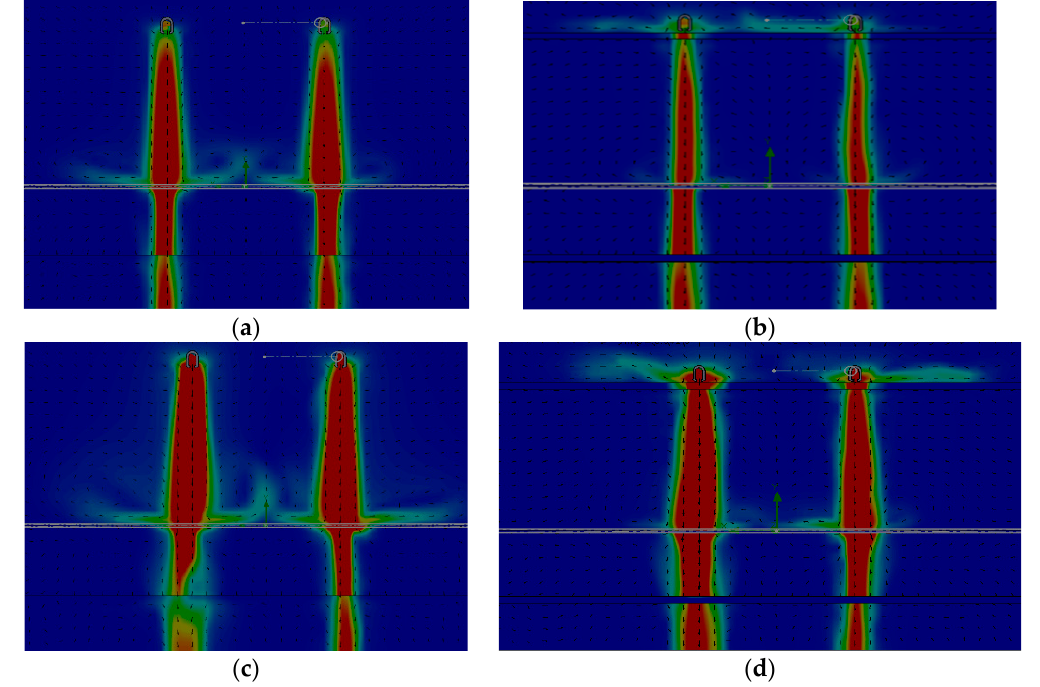
Figure 13. Fluid flow rate distribution patterns for: Q = 0.00025 m 3 /s: ( a ) without metal pad mesh and ( b ) with metal pad mesh; Q = 0.000666 m 3 /s: ( c ) without metal pad mesh and ( d ) with metal pad mesh.